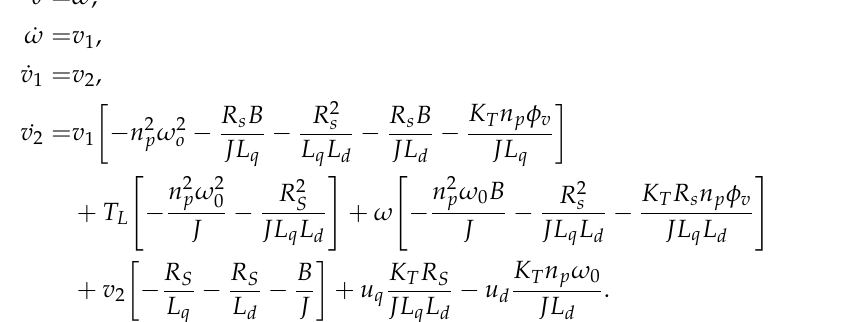
4D PMSM model in the following four